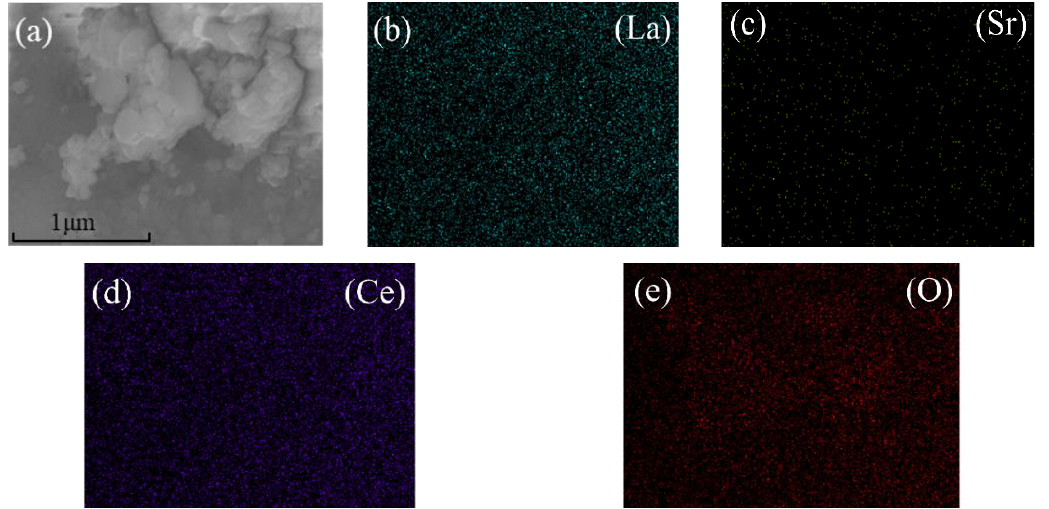
Figure 3. SEM-EDS mapping images of the fresh La 0 . 6 Sr 0 . 4 CeO 3- δ : ( a ) the selected area of SEM-EDS mapping; ( b ) lanthanum; ( c ) strontium; ( d ) cerium; ( e ) oxygen. Table 1. The SEM-EDS data of the La 0 . 6 Sr 0 . 4 CeO 3- δ sample.